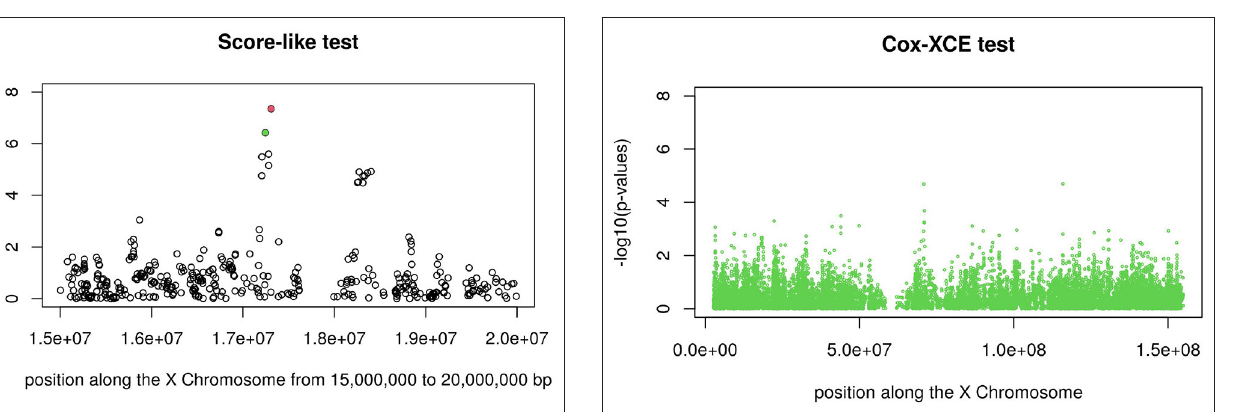
FIGURE 4 | Manhattan plot of X Chromosome genome-wide association results (Score-like test) with zoom in on area 15,000,000–20,000,000 with